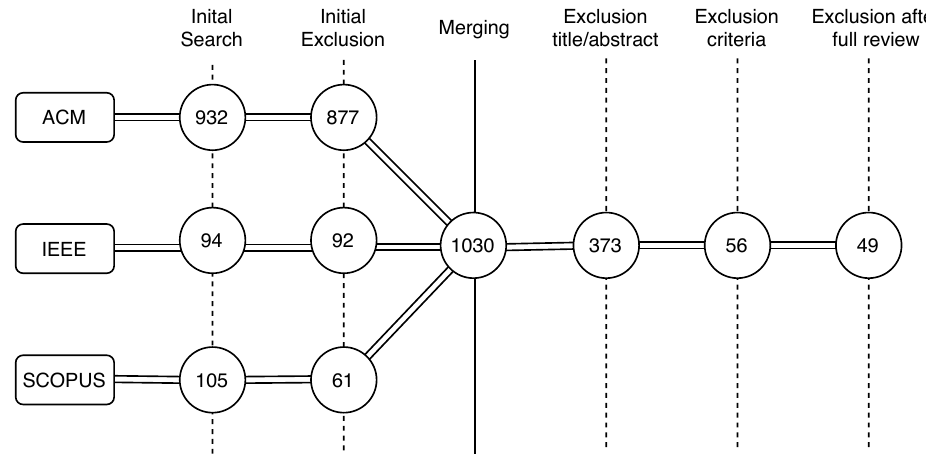
Figure 4. Mapping study steps for searching and selecting the final set of